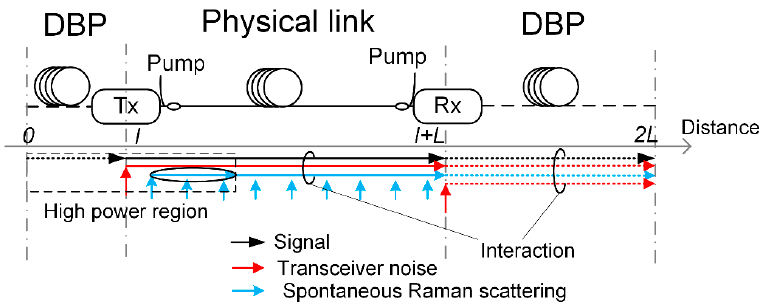
Figure 2. NSNI in a bi-directional Raman amplified system with split-DBP.